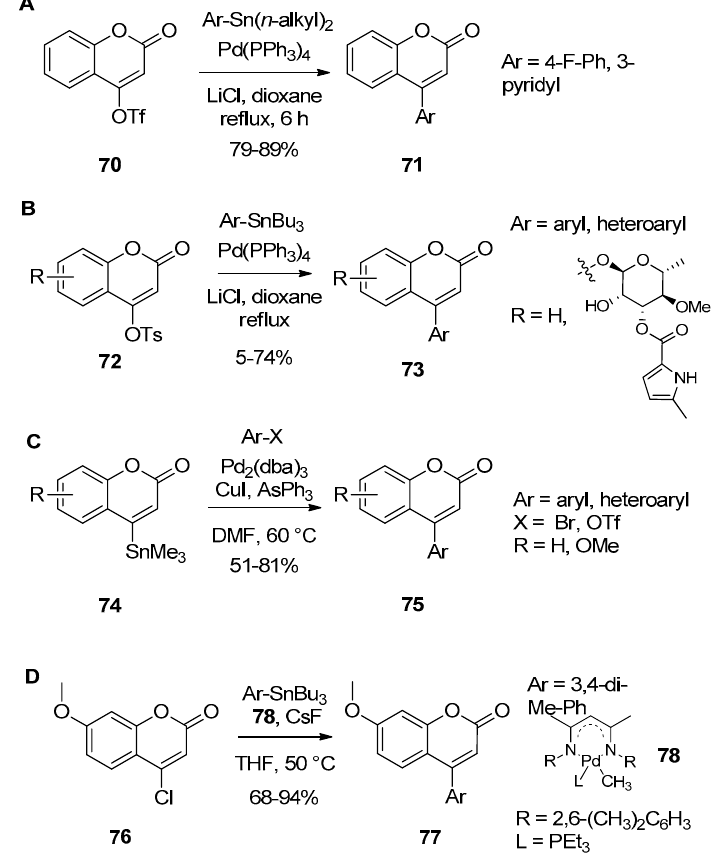
Scheme 14. Synthesis of 4-arylcoumarins via Pd(0)-catalyzed Stille reaction using 4-triflated coumatins ( A ), 4-tosylated coumarins ( B ), 4-stannylcoumarins ( C ) and 4-chlorocoumarin ( D )